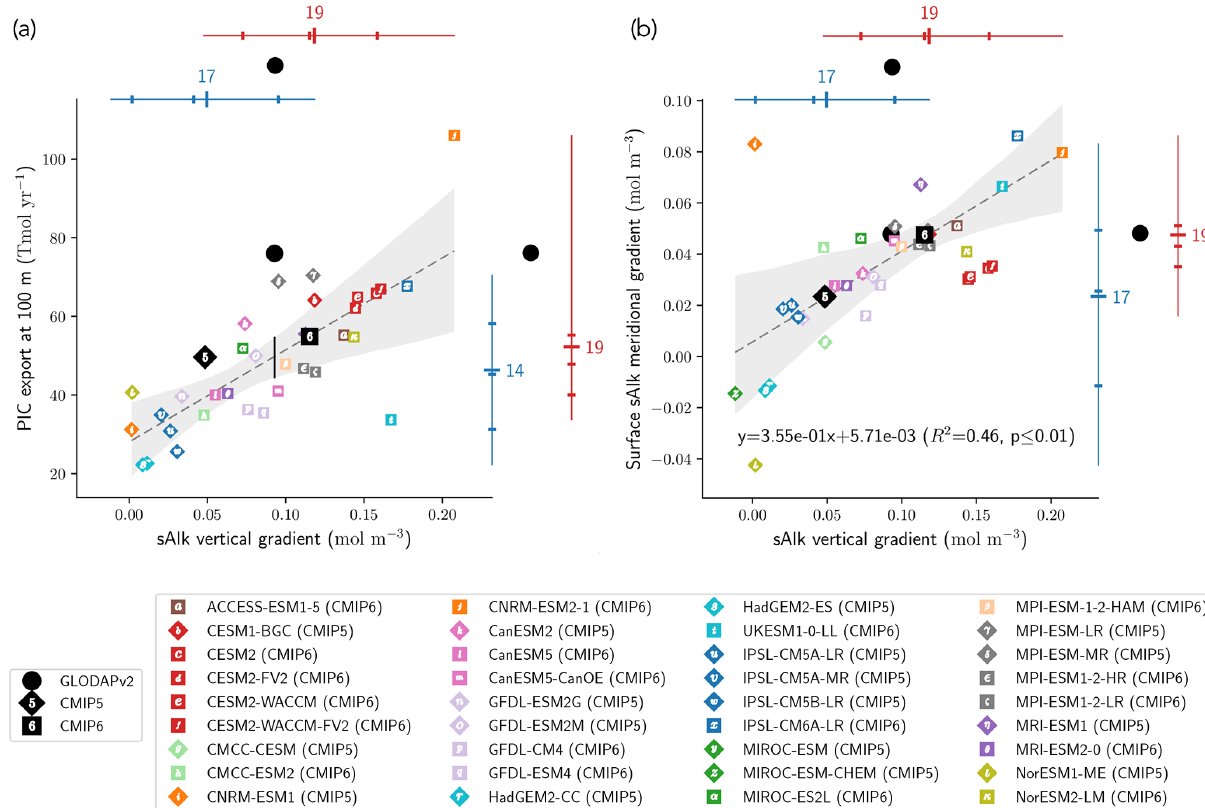
Figure 8. Relationship between the open-ocean vertical gradient of sAlk and the (a) globally integrated PIC export at 100m and (b) surface sAlk meridional gradient between the Southern Ocean and the low latitudes. Marker notation is as in Fig. 4 with CMIP5 (CMIP6) ESMs shown as diamonds (squares). The CMIP5 (blue) and CMIP6 (red) ensemble ranges (line), mean (major tick) and quartiles (minor ticks) are displayed with the number of ESMs. GLODAPv2 observations (black circles) of the sAlk vertical gradient, combined with the estimated linear regression and 95% confidence intervals, infer present-day global PIC export at 100m of 44 to 55Tmolyr − 1